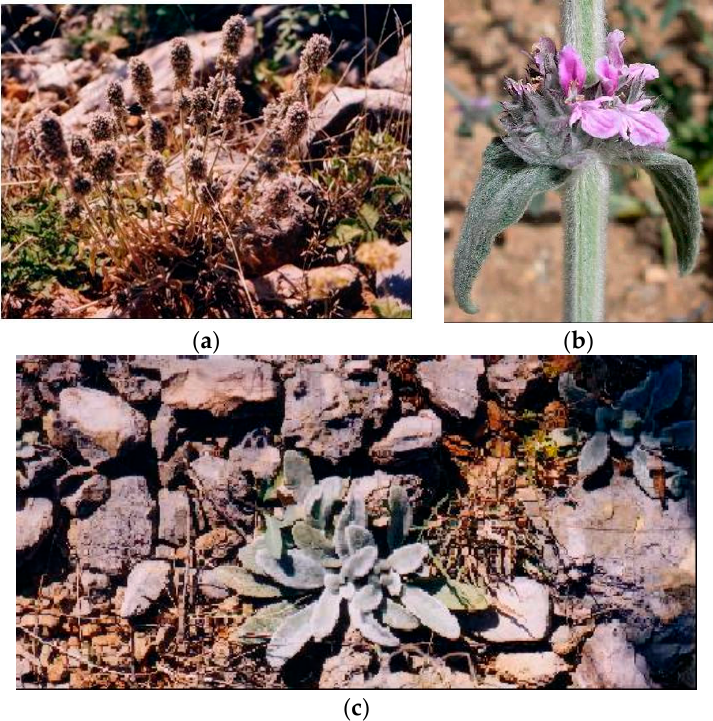
Figure 8. Stachys germanica L. (by courtesy of Saxifraga Foundation).